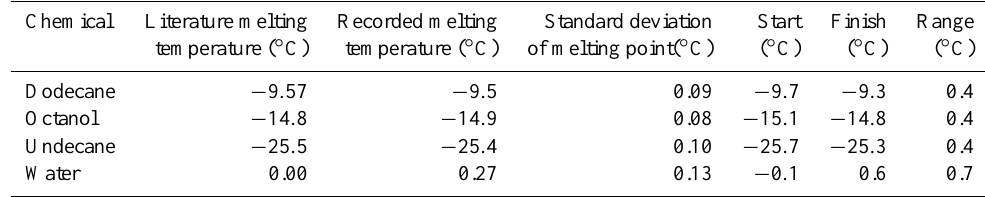
Table 1. Melting points of solvents used to calibrate temperature of the µl-NIPI. Recorded melting points are the average of five measure- ments. Literature melting points were taken from the 2007 CRC hand book.